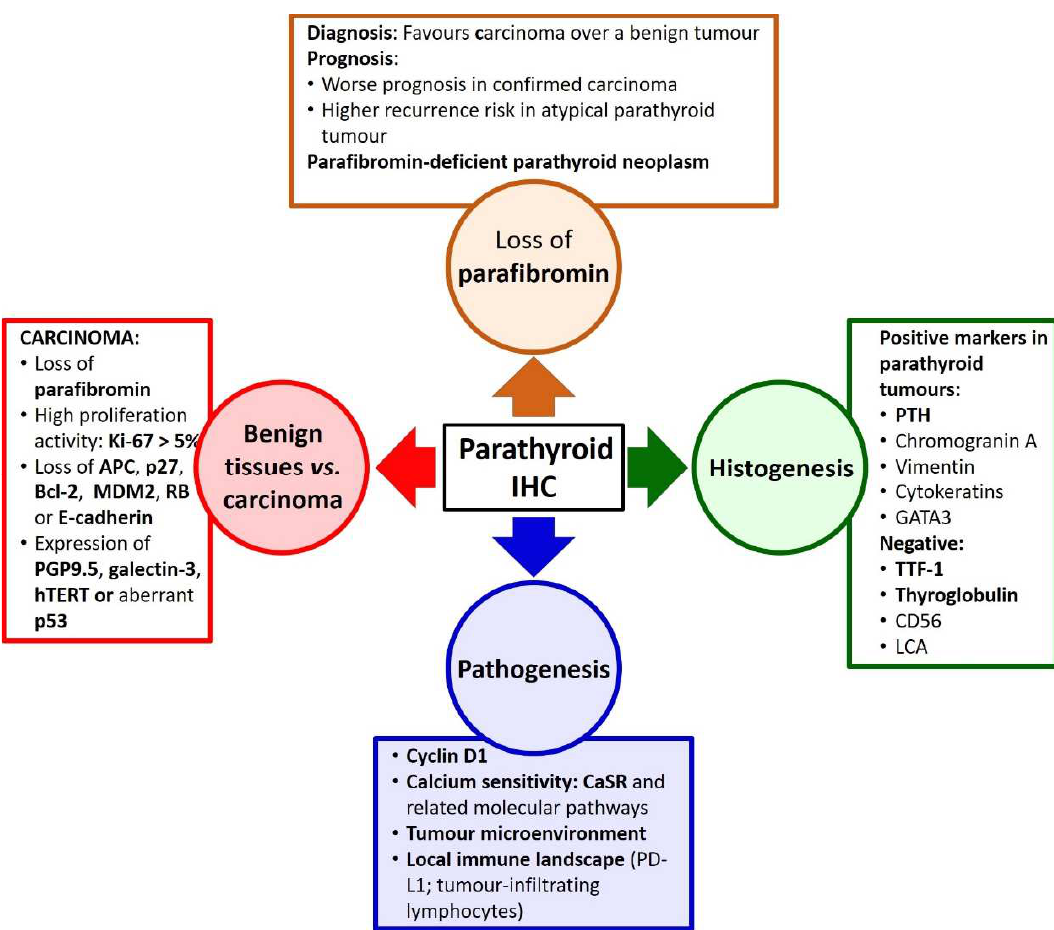
Figure 1. Applications of immunohistochemistry in parathyroid pathology.